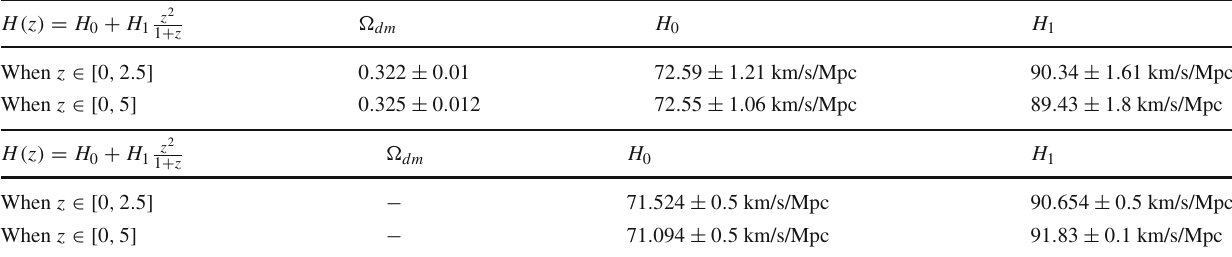
Table 2 Best fit values and 1 σ errors estimated for Model 1, Eq. (14), for z ∈ [ 0 , 2 . 5 ] and for z ∈ [ 0 , 5 ] , respectively. The results depicted in the first part of the table are obtained from the generative process based onSC1,Eq.(1).Thesecondpartofthetablecorrespondstotheresultsof the fit when the theoretical form of the expansion rate, Eq. (14), is used